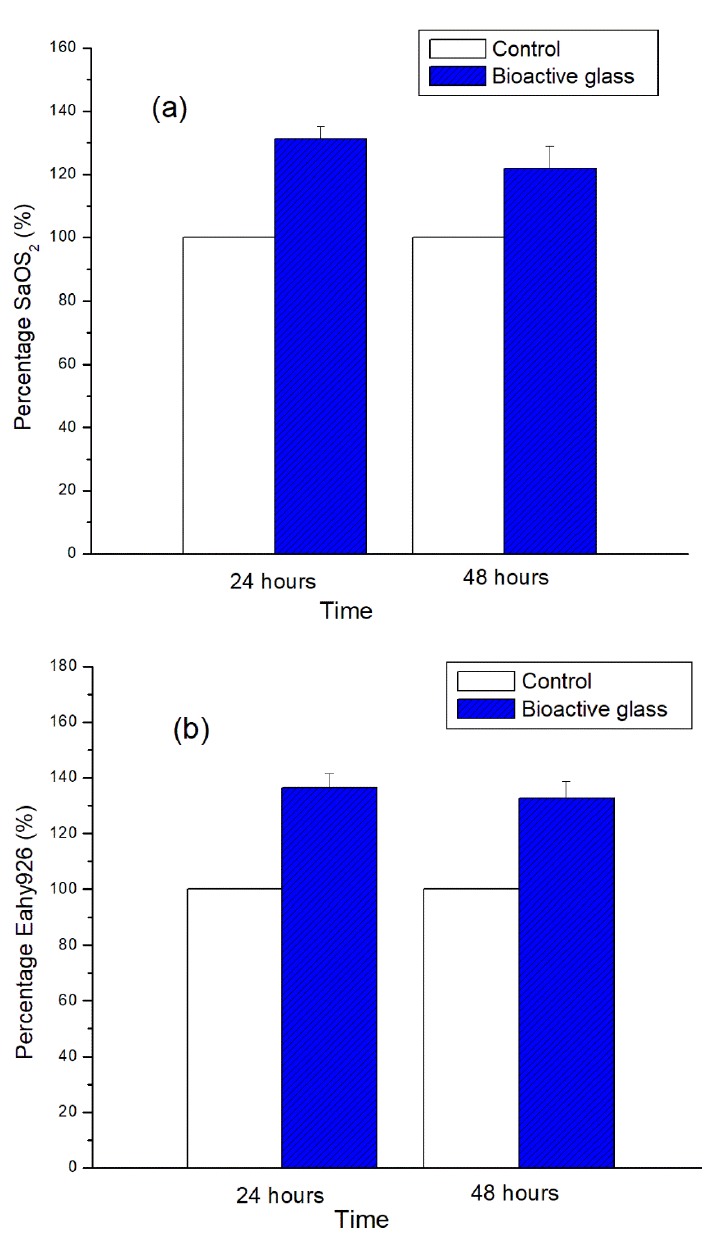
Figure 6. Cellular viabilities on bioactive glass after 24 h and 48 h: ( a ) for osteoblast cells SaOS 2 and ( b ) for endothelial cells Eahy926.